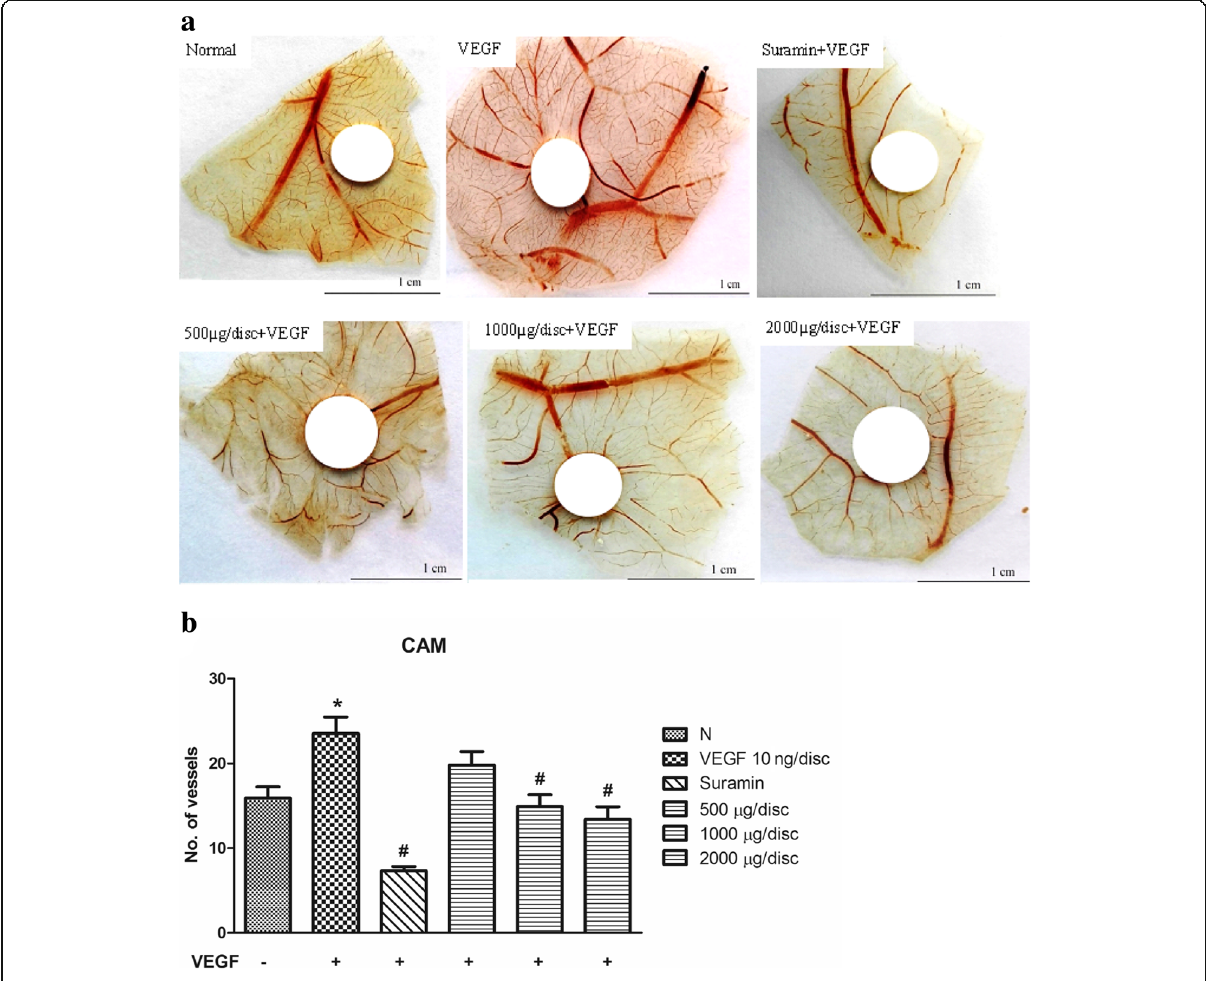
Fig. 9 Effect of C. nutans water extract on VEGF-induced angiogenesis. Suramin at a dose of 1000 μ g/disc was used as a positive control. a C. nutans extract inhibited vessel sprouting in CAM model induced by VEGF. Representative results were shown. b The histogram shows the number of blood vessels contacting the discs. The values presented are the mean ± SEM of three independent experiments. * p < 0.05 were considered significant when compared to normal control (N); # p < 0.05 were considered significant when compared to VEGF alone